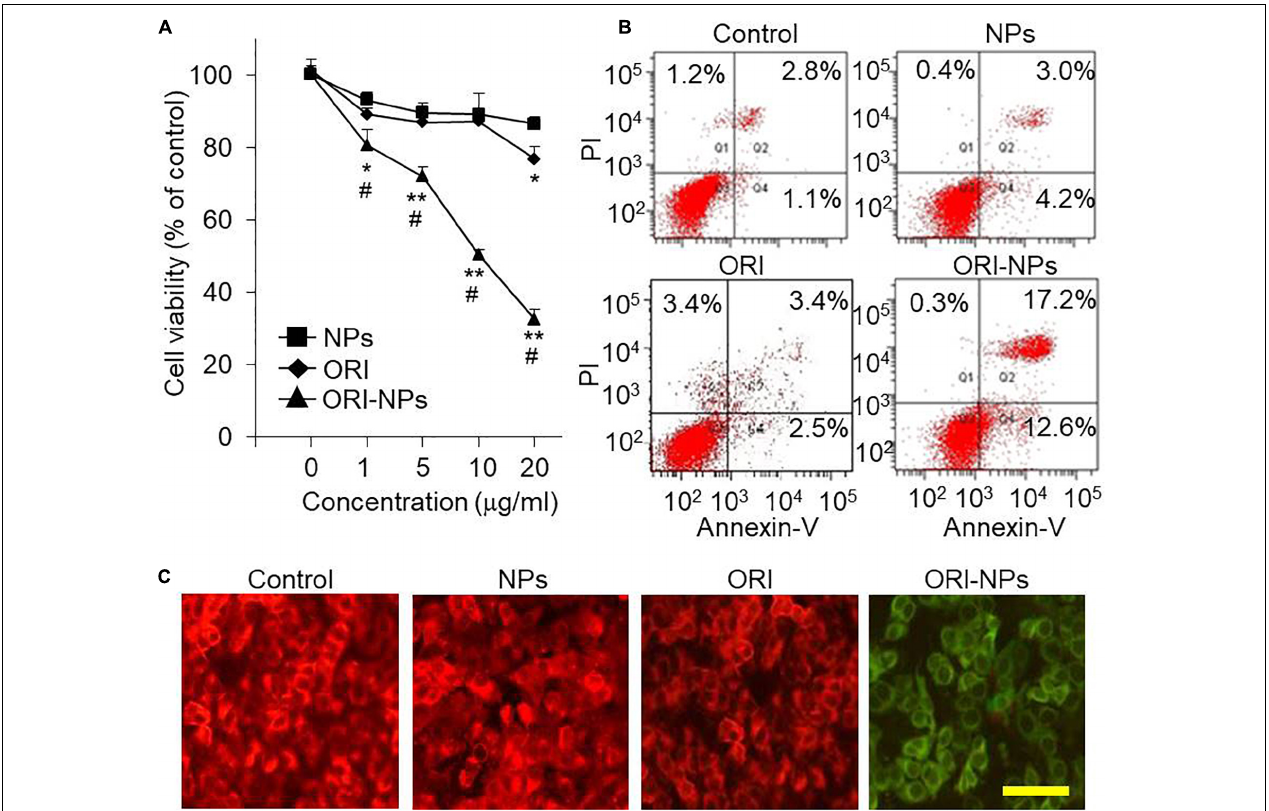
FIGURE 3 | ORI-NPs decreases the cell viability and induced apoptosis of the MCF-7 cells. (A) MTT assay demonstrating the inhibitory effects of compounds on the cell viability of MCF-7 cells. After the treatment for 24 h, the cell viability was assessed by MTT assay. (B) Cell apoptosis of the MCF-7 cells measured by fluorescence-based flow cytometry analysis. The cells were treated with 10 µ g/ml of ORI, blank-NPs or ORI-NPs for 24 h, and then stained with Annexin V/PI for cell apoptosis analysis. (C) Representative images of MCF-7 cells stained with JC-1 demonstrating the changes of mitochondrial membrane potential. Scale bar = 20 µ m. (Data were representative three independent experiments. * P < 0.05, ** P < 0.01 versus blank